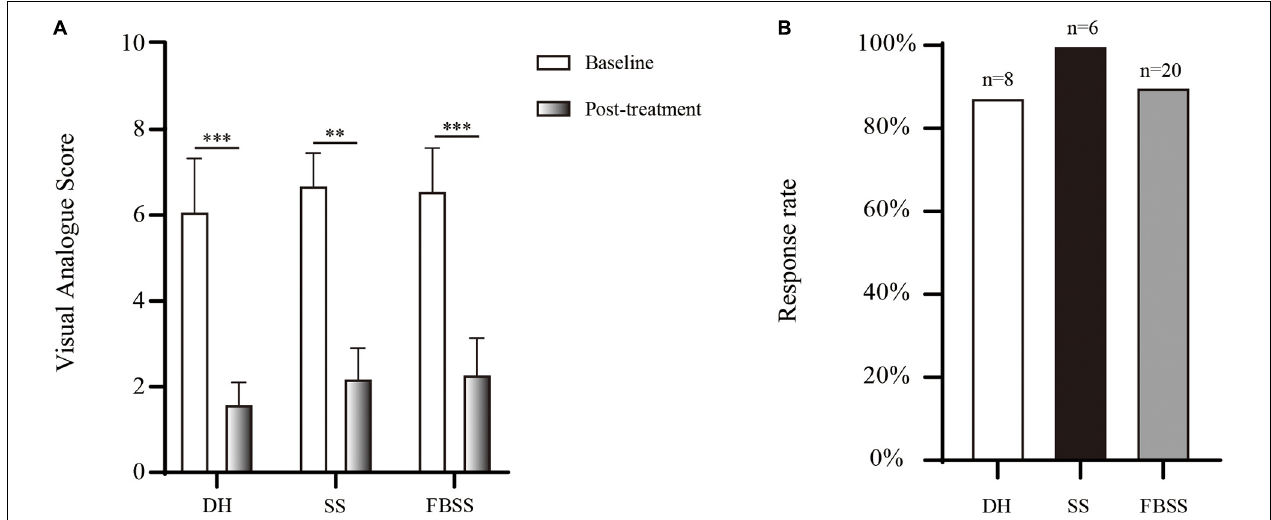
FIGURE 3 | The initial analgesic effect provided by PRF and TESI. (A) Changes of pain score between pre- and post-treatment. (B) The initial response rate of each group. ∗∗ p < 0.01, ∗∗∗ p < 0.001.